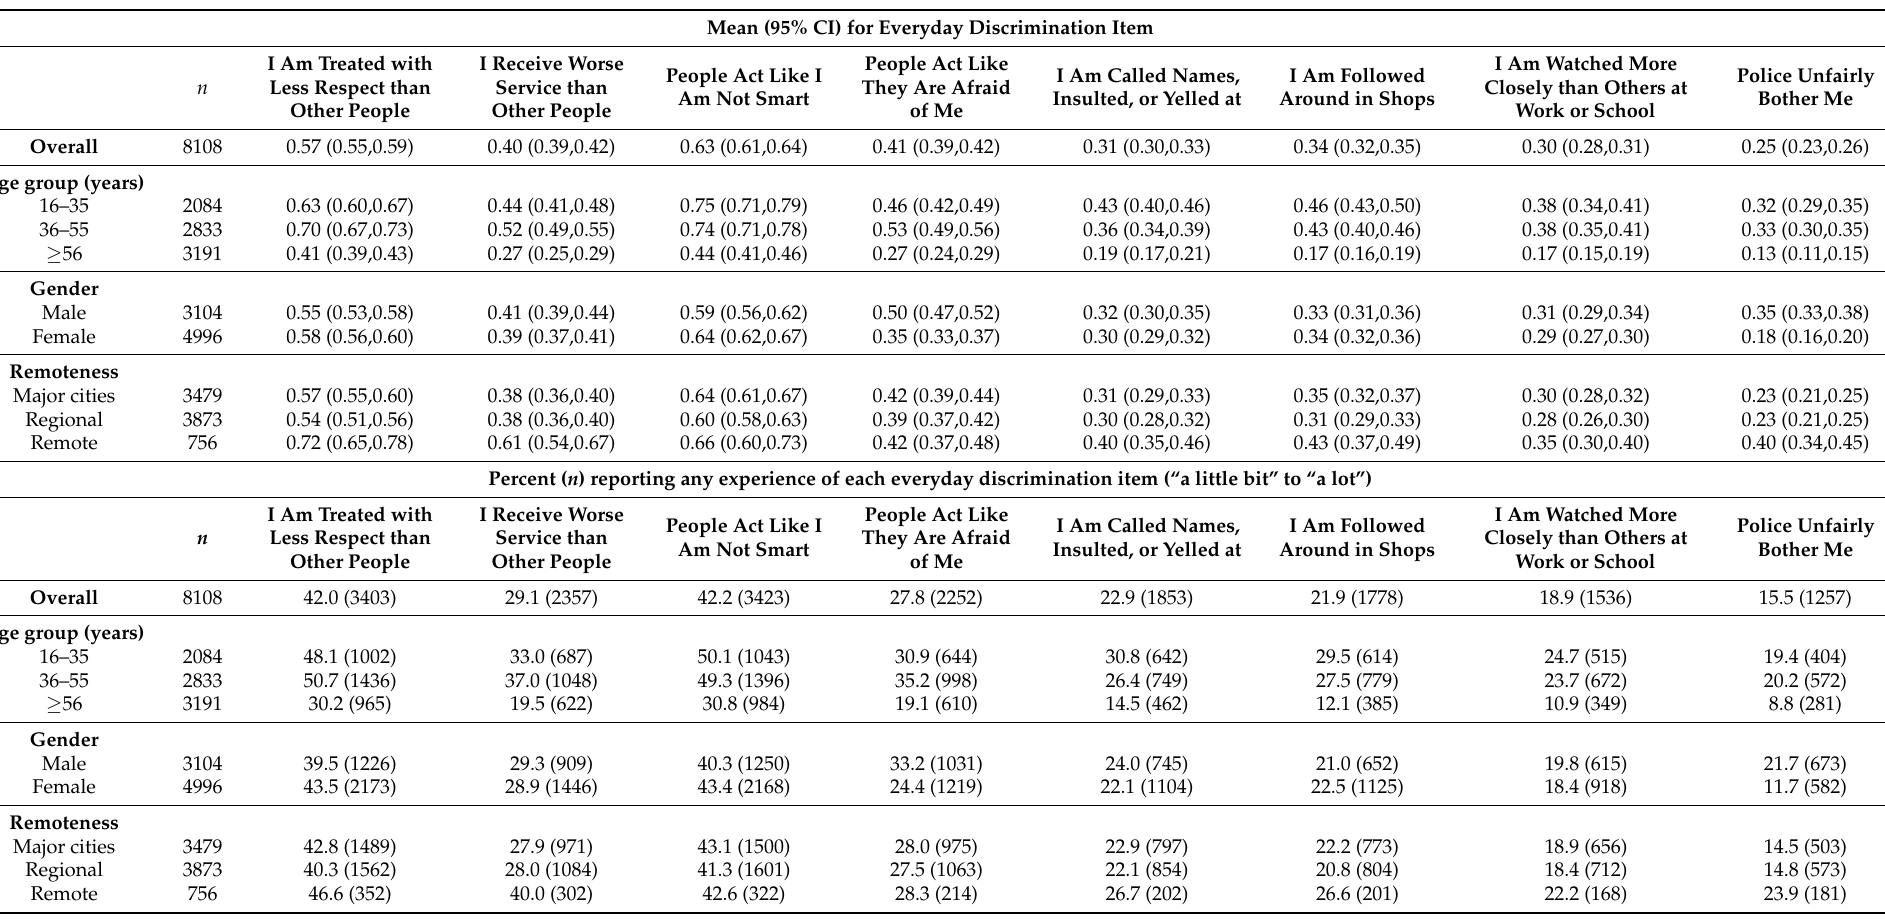
Table 2. Mean (95% CI) and per cent ( n ) endorsing each everyday discrimination items, overall and by demographic characteristics ( n = 8108). Mean (95% CI) for Everyday Discrimination